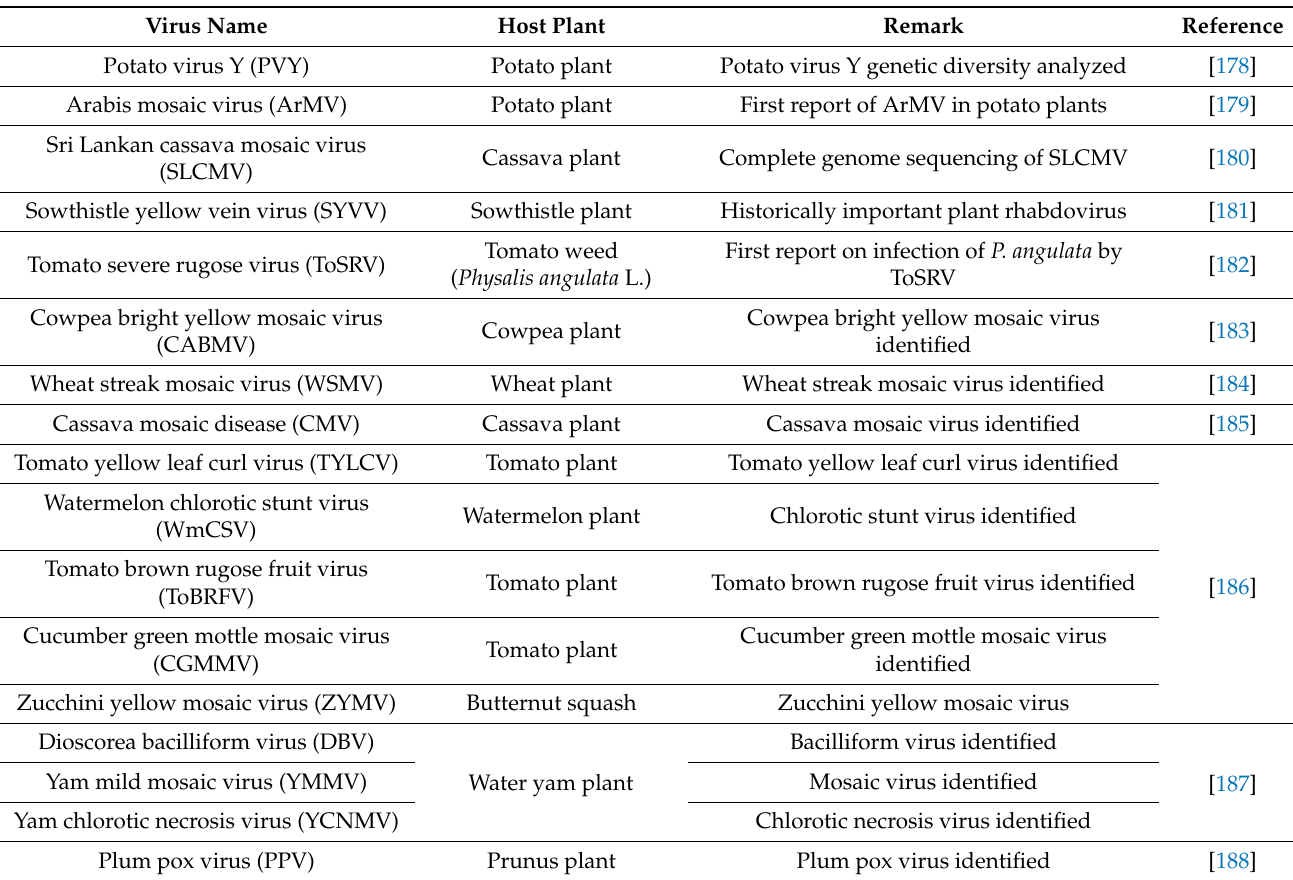
Table 4. Next-generation sequencing (third-generation: MinION Nanopore)-based identification of causative agents associated with the viral diseases of various